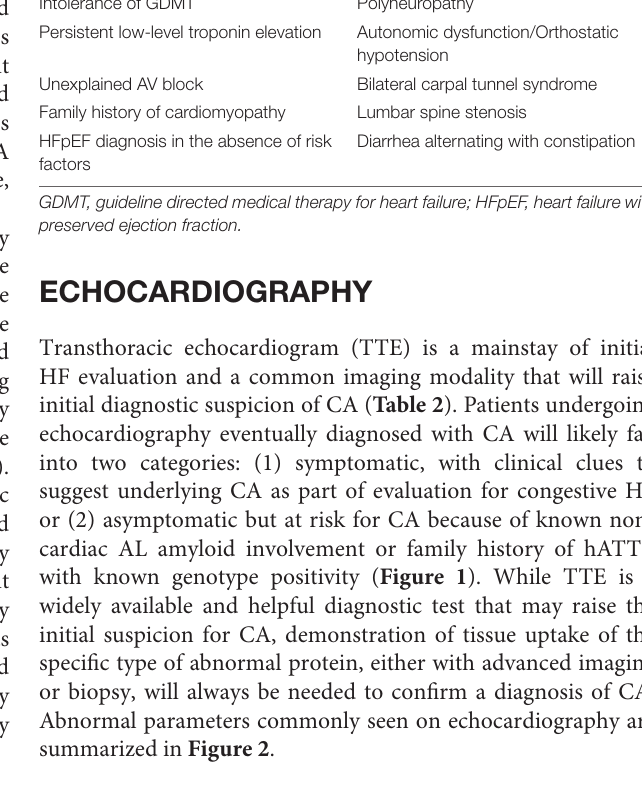
TABLE 1 | Cardiac and non-cardiac clinical clues for possible ATTR-CA. Non-imaging cardiac red flags for ATTR-CA Intolerance of